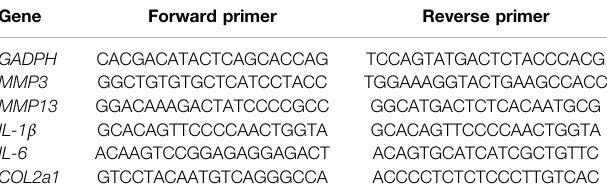
TABLE 1 | Primers in qRT-PCR